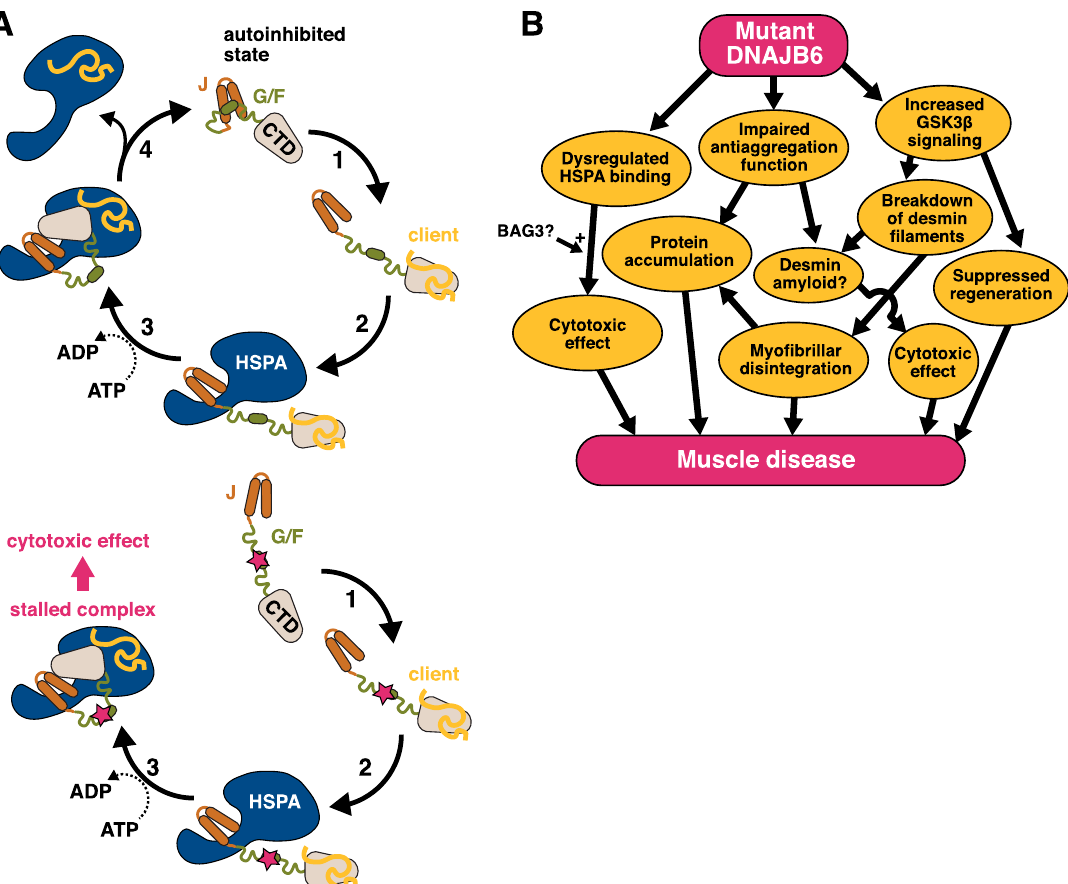
Figure 4. The pathomechanism of DNAJB6 mutations. ( A ) Top: The suggested function of DNAJB6 in the HSPA cycle: (1) Client binding by DNAJB6. (2) HSPA binding to JD. (3) ATP hydrolysis and client transfer to HSPA. (4) Displacement of HSPA by the G / F domain. Adapted from [28]. Bottom: A model for the e ff ect of myopathy mutations. The mutations interfere with the interaction between the J and G / F domains, leading to uncontrolled interaction with HSPA. ( B ) Possible parallel downstream pathways leading from DNAJB6 mutations to muscle